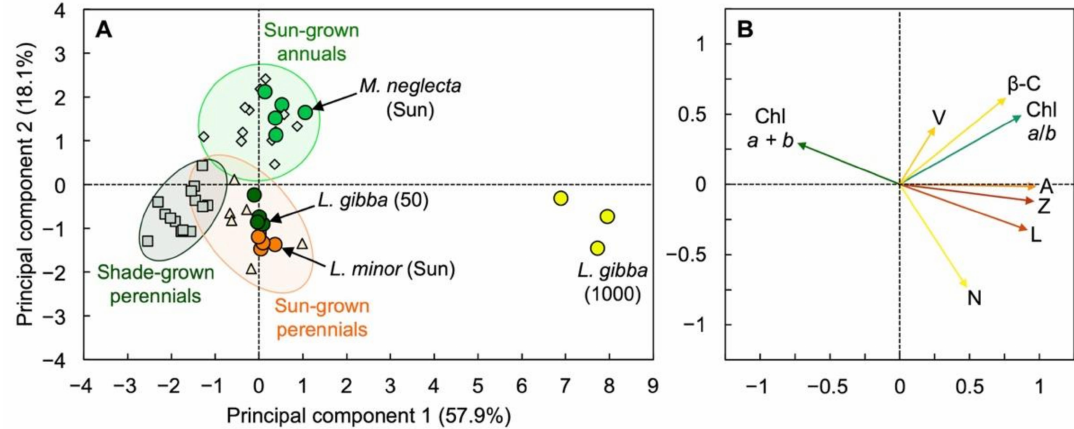
Figure 10. ( A ) Score and ( B ) loading plots of the first two principal components from principal component analysis on correlations of chlorophyll (Chl) a + b per leaf/frond area, Chl a / b molar ratio, and levels of violaxanthin (V), β -carotene ( β -C), antheraxanthin (A), zeaxanthin (Z), lutein (L), and neoxanthin (N) per Chl a + b in fronds of Lemna gibba grown under PFDs of 50 (dark green circles) and 1000 (bright yellow circles) µ mol m − 2 s − 1 in growth chambers, and fronds of sun-grown Lemna minor (bright orange circles), leaves of sun-grown Malva neglecta (bright green circles), and a variety of sun-grown annuals (light green diamonds), shade-grown perennials (gray squares), and sun-grown perennials (light orange triangles). For details, see Tables S1–S3 and